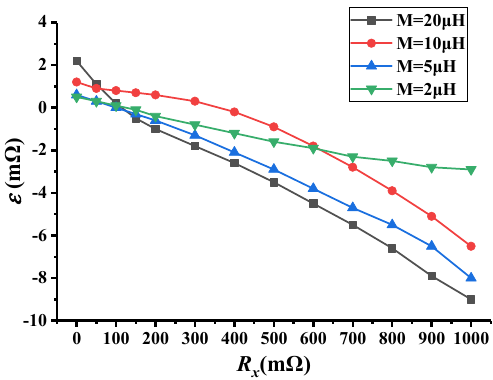
Figure 8. Detection error curve .